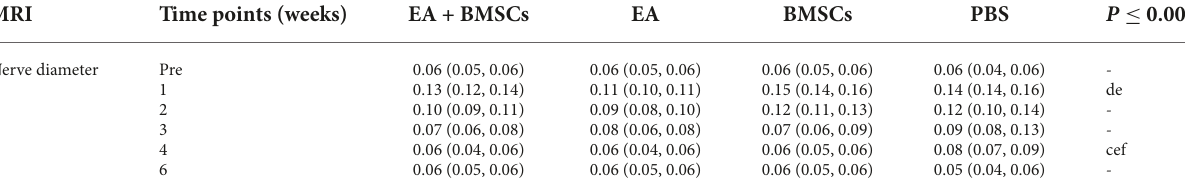
TABLE 1 Nerve diameter in EA + BMSCs, EA, BMSCs, and PBS [M (P25, P75)].